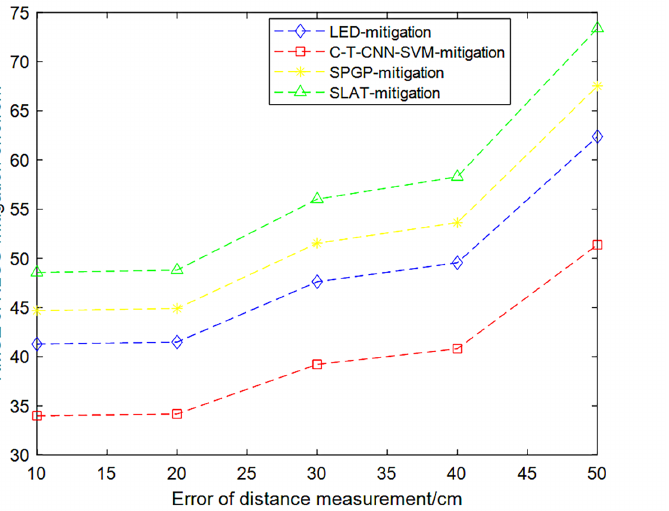
Figure 9. Comparison of NLOS mitigation performance between the proposed and other state-of-the- art